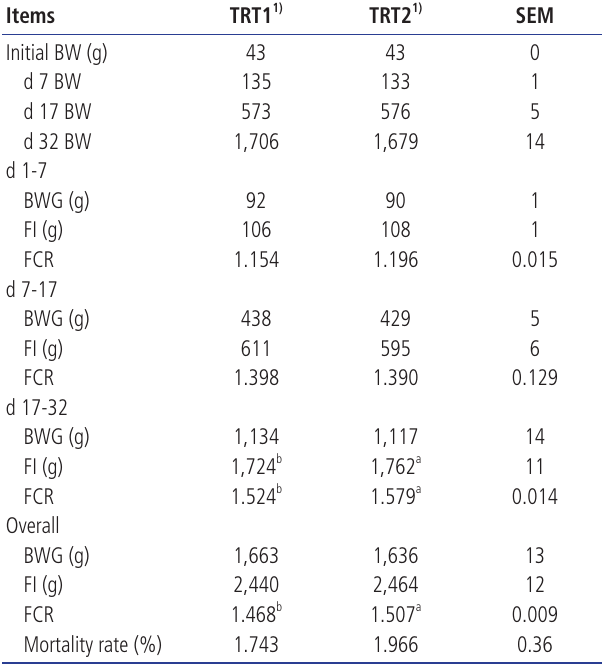
Table 5. Effect of GMO and non-GMO corn-SBM diets on growth performance of broilers Items TRT1 1)